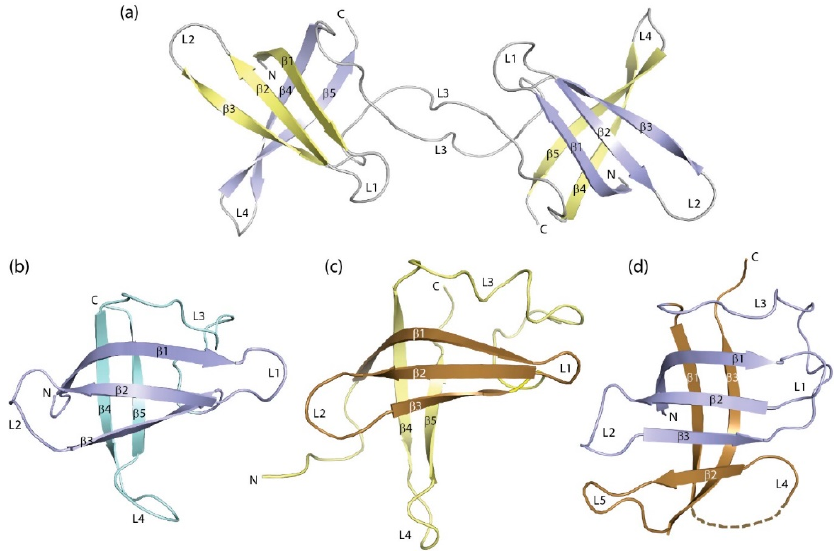
Figure 4. Domain- and segment-swapped forms of the cold-shock protein. ( a ) Bc CspB domain- swapped dimer ([113], PDB entry 2hax). Protein-bound DNA strands were omitted for the sake of clarity. ( b ) Crystal structure of Ec CspA ([95], PDB entry 1mjc) and ( c ) NMR structure of the S1 domain of E. coli polynucleotide phosphorylase ([117], PDB entry 1sro). Strands β 1- β 3 of both proteins that recombine to form 1b11 are highlighted by darker colors. ( d ) Structure of combinatorial protein 1b11 ([118], PDB entry 2bh8). Drawings prepared with PyMOL [101].